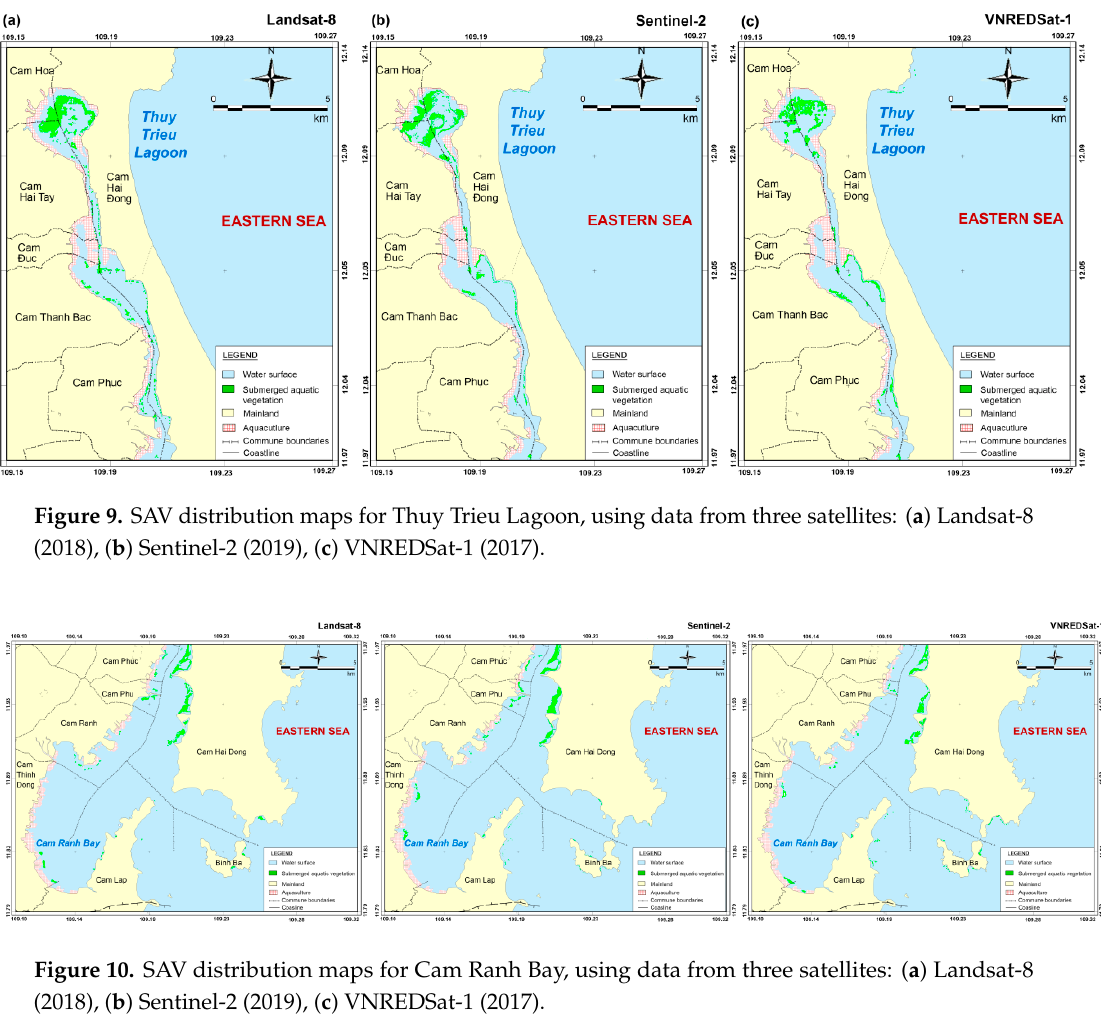
Figure 10. SAV distribution maps for Cam Ranh Bay, using data from three satellites: (a) Landsat-8 (2018), (b) Sentinel-2 (2019), (c) VNREDSat-1 (2017).